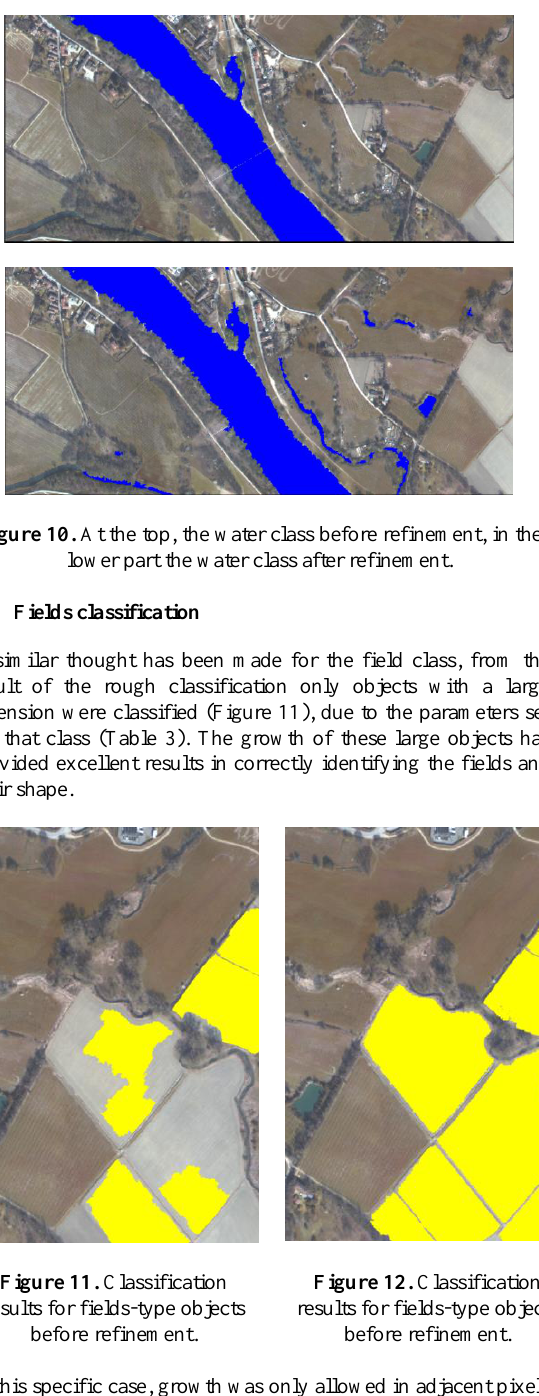
Figure 12. Classification results for fields-type objects